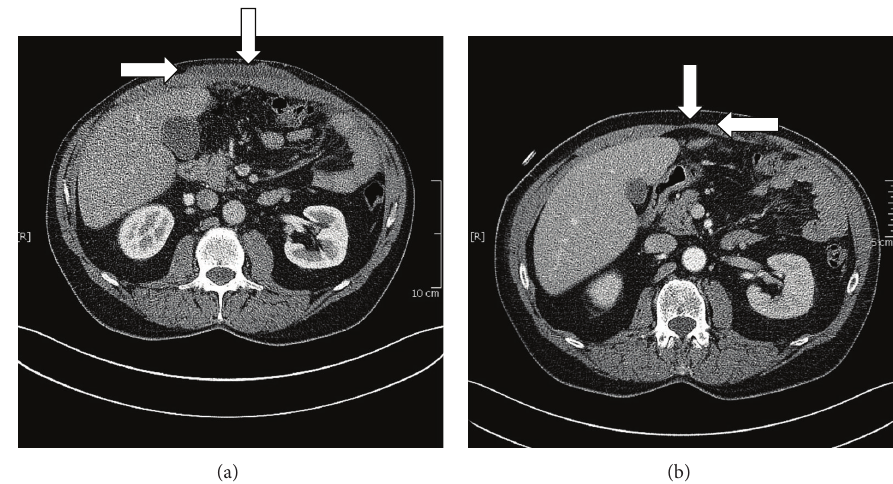
Figure 3: (a) Large subcutaneous metastasis of the abdominal wall before chemotherapy, (b) remission of the subcutaneous metastasis after 6 cycles of chemotherapy.